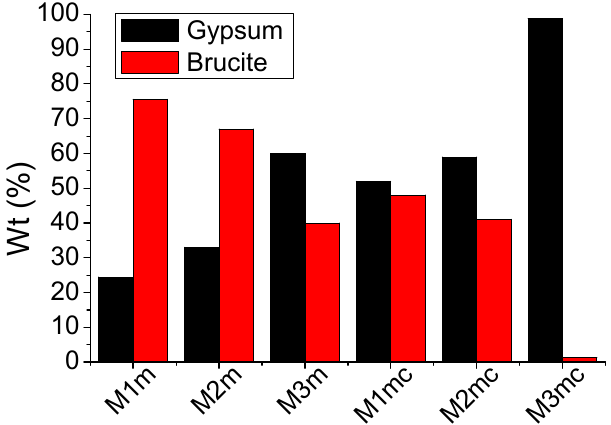
Figure 13. The formation of gypsum and brucite (% weight) of all the examined coatings after acid spraying with sulfuric acid solution (4 M) for 10 days, using daily the 17% of the respective reaction’s stoichiometry.